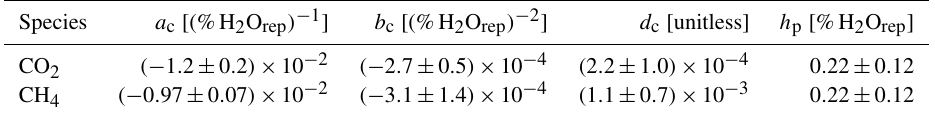
Table B1. Synthesis water correction coefficients. Uncertainties are approximated by the maximum difference between the coefficients of the individual water correction functions and the coefficient of synthesis